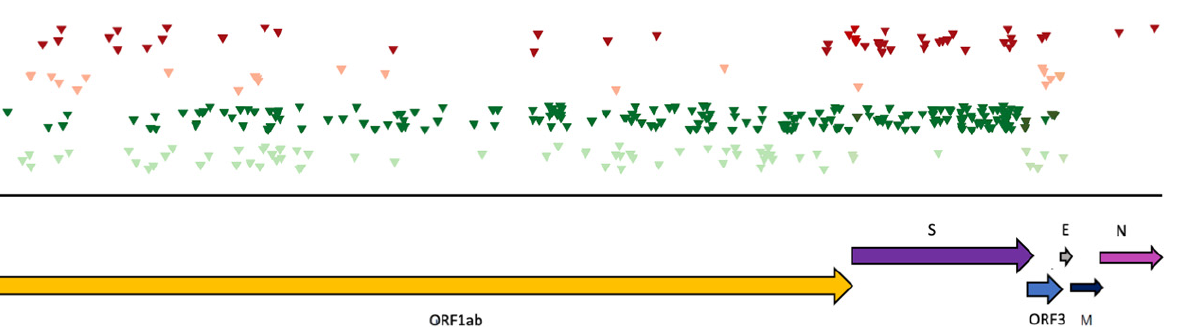
Figure 7. Overview of SNVs distributed over the genome of the alpha-CoV from the LU colony. Arrows show the position of the ORFs. Each triangle indicates an SNV; light green, synonymous and novel; dark green, synonymous; light red, non-synonymous and novel; dark red, non-synonymous.